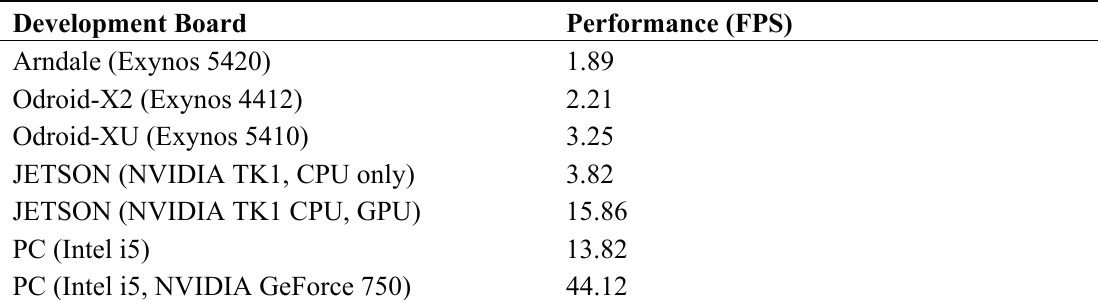
Table 3. Comparison of recognition processing performance.